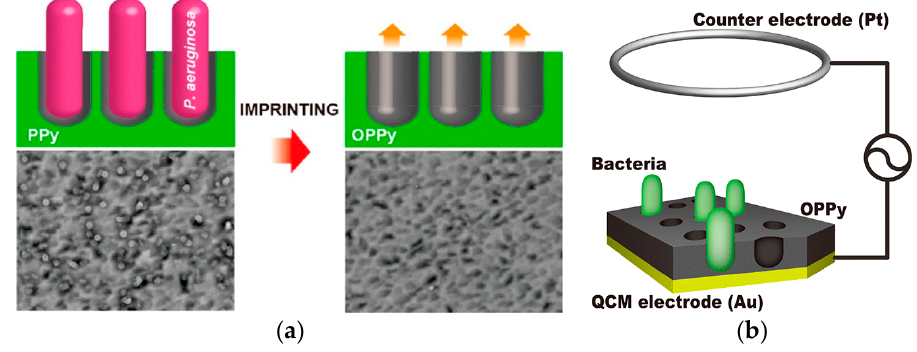
Figure 13. ( a ) Illustration depicting imprinting Pseudomonas aeruginosa bacteria on a polypyrrole (PPy) film and ( b ) electrode configuration for label free detection with the PPy film (adapted with permission from [50]. Copyright (2013) American Chemical Society).